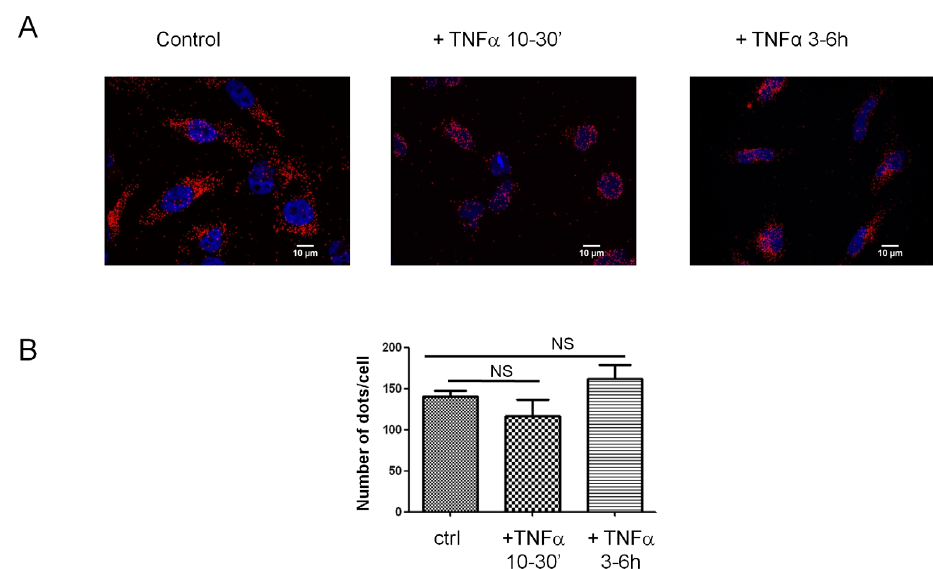
Figure 8. Keratin 8-F508del-CFTR proximity in HeLa cells. A . Differential interaction between K8 and CFTR in cells treated with TNF α (50ng/ml) for varied durations. DNA proximity ligation assay of K8 and CFTR in HeLa cells transfected with F508del-CFTR, scale bar = 10 µm. B . Number of dots corresponding for proteins pairs, Keratin 8 –F508del-CFTR, per cell. NS, not significant.